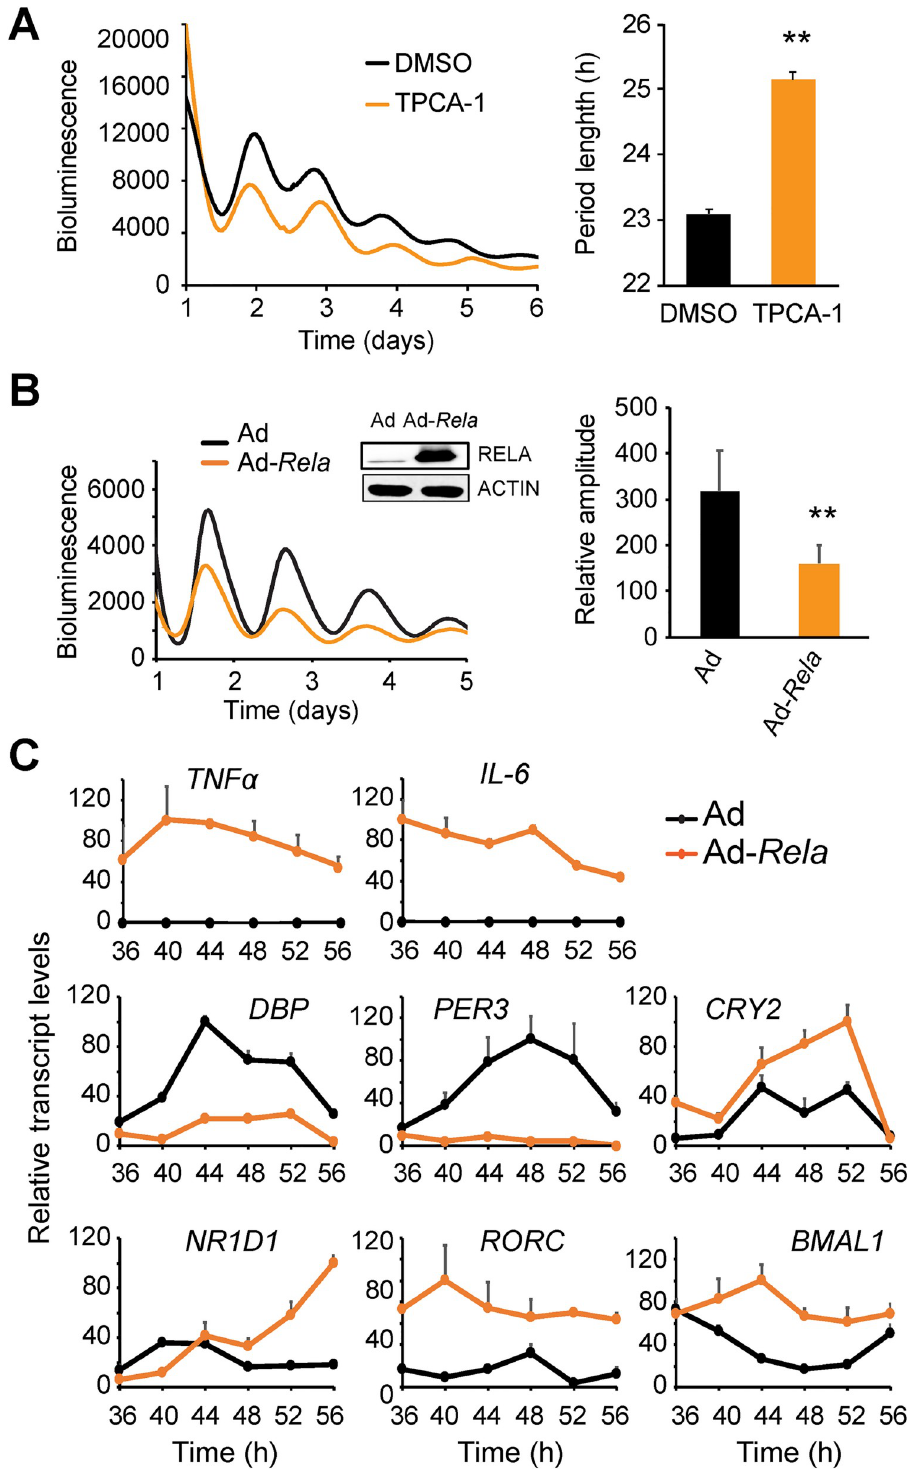
Fig 1. NF- κ B affects clock gene expression and circadian rhythms in U2OS cells. (A-B) Bioluminescence rhythms in U2OS cells harboring the Per2-dLuc reporter were recorded in a Lumicycle luminometer. In (A), cells were treated with IKK2-specific inhibitor TPCA-1 (5 μ M). IKK2 inhibition caused long period length compared to DMSO control. Traces are representative bioluminescence recordings. Period lengths are mean ± standard deviation (SD) of n = 6